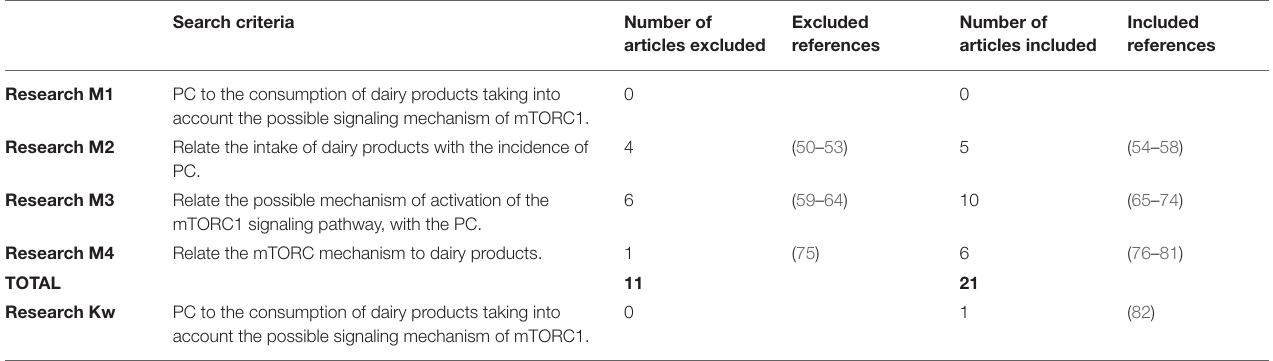
TABLE 1 | Search Results (Kw–search with keywords and no MeSH